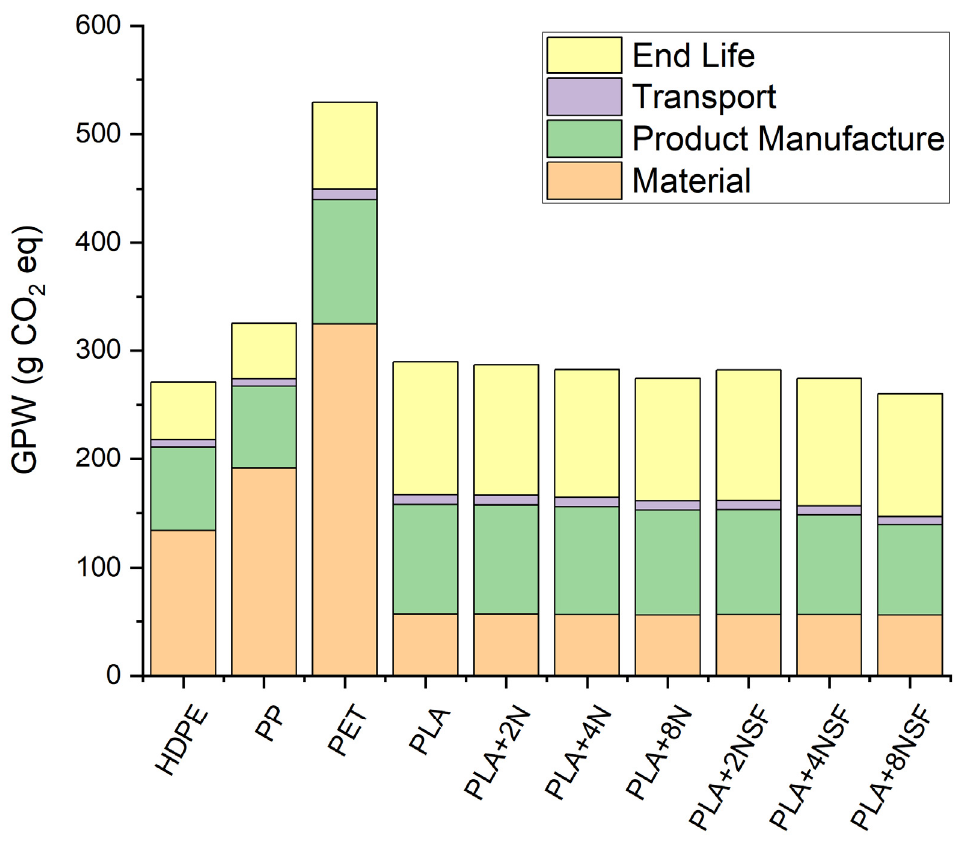
Figure 12. LCA results for analyzed materials in terms of CO 2 equation.